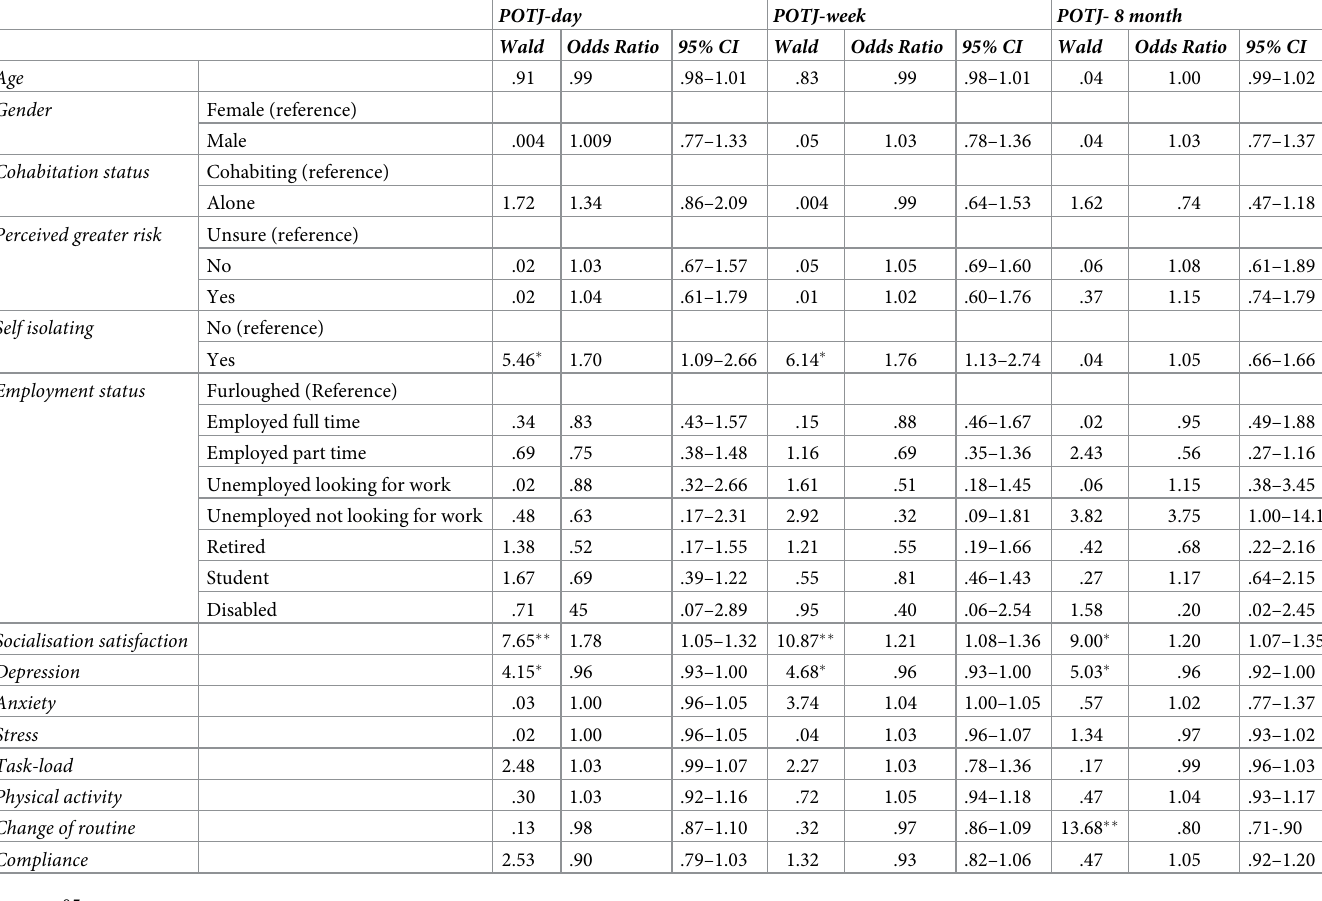
Table 4. Wald, odds ratios and 95% confidence intervals from the ordinal regressions for POTJ-day, POTJ-week and POTJ-8